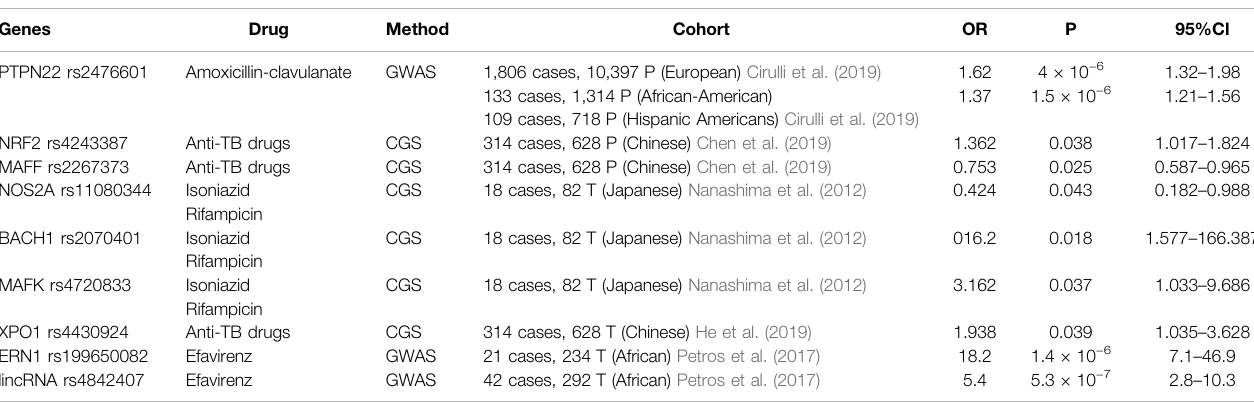
TABLE 4 | Other polymorphisms of DILI-related genes identi fi ed in GWAS and CGS. Genes PTPN22